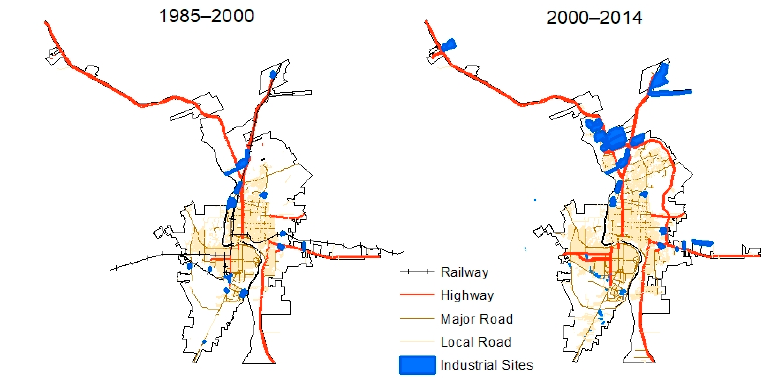
Figure 4. Spatial distribution of transportation network and industrial sites used as proximity factors.